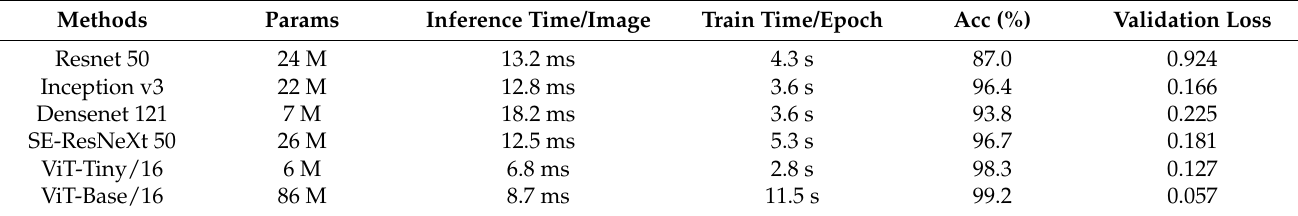
Table 3. Performance of ViT compared to CNN networks.